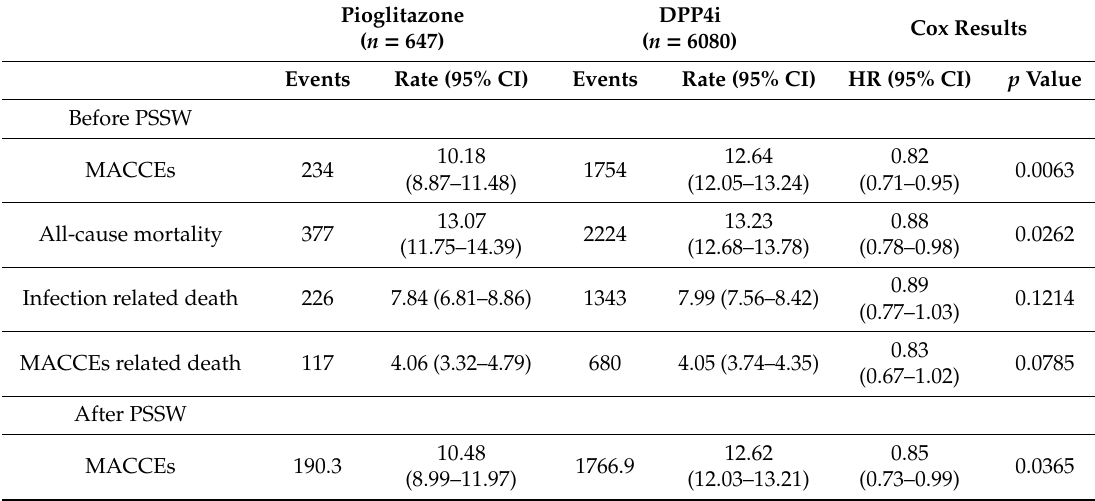
Table 2. Incidence rate (per 100 person-year) and hazard ratio (HR) of primary and secondary outcomes for diabetic patients with end-stage renal